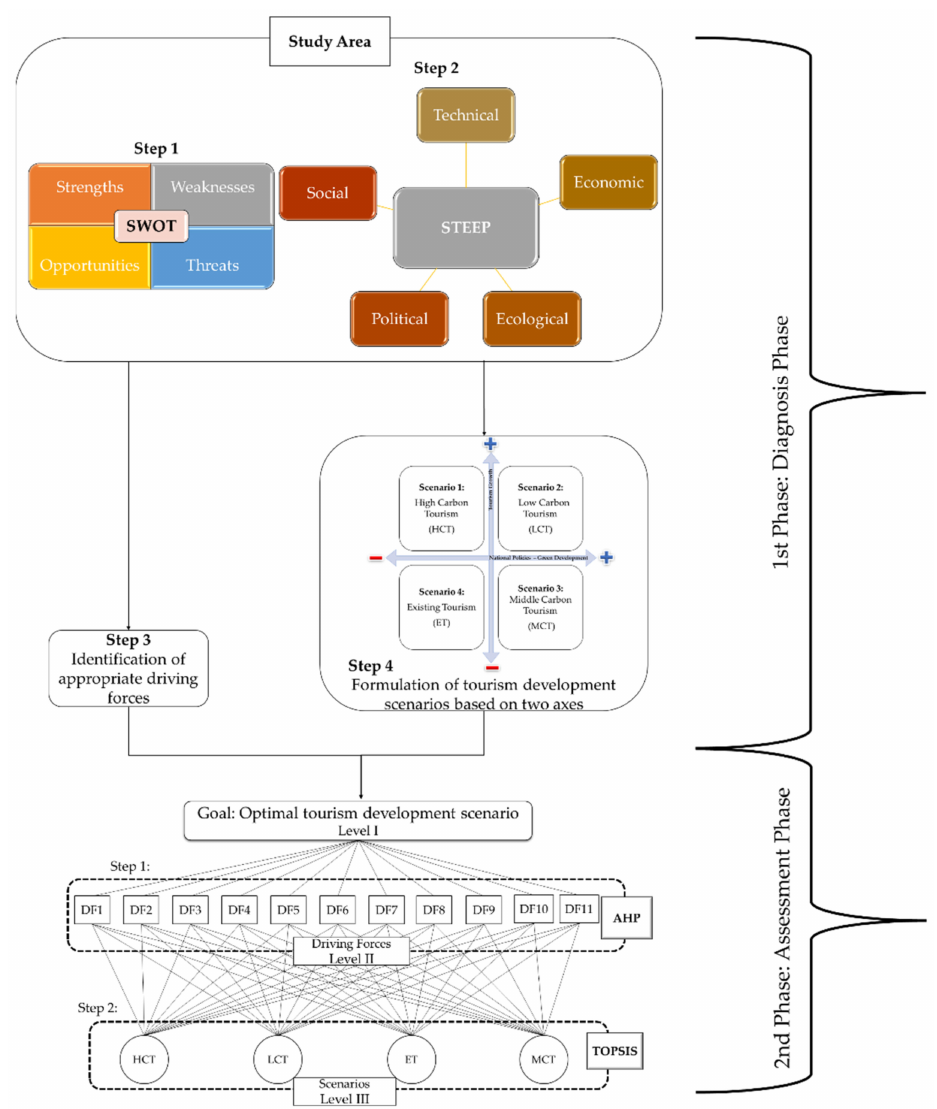
Figure 3. Methodological